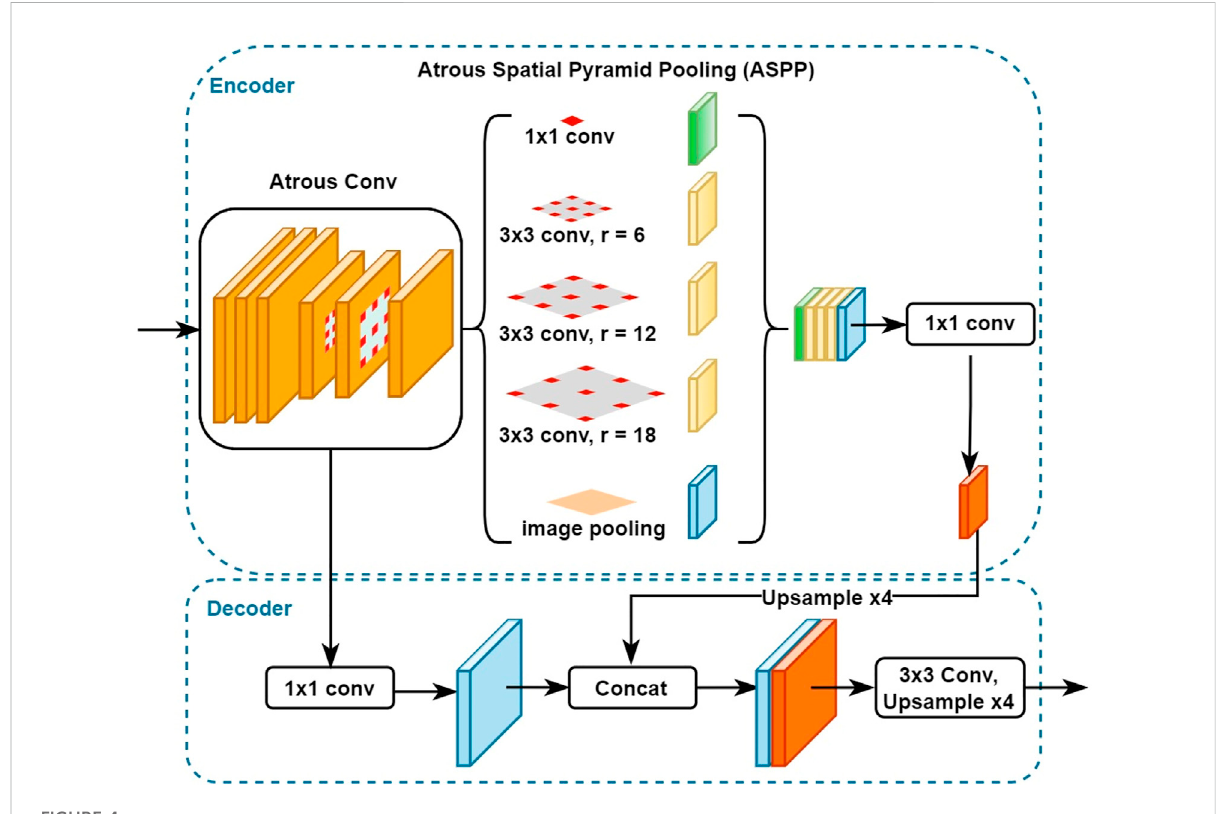
FIGURE 4 The architectures of DeepLabv3+